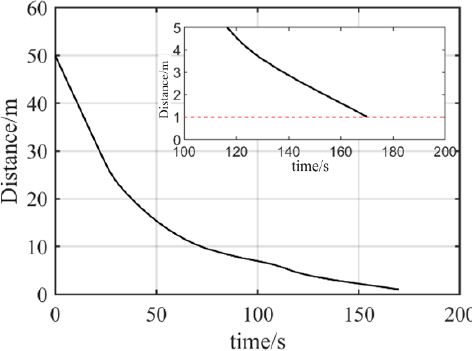
Figure 6. Distances between pursuer and evader.